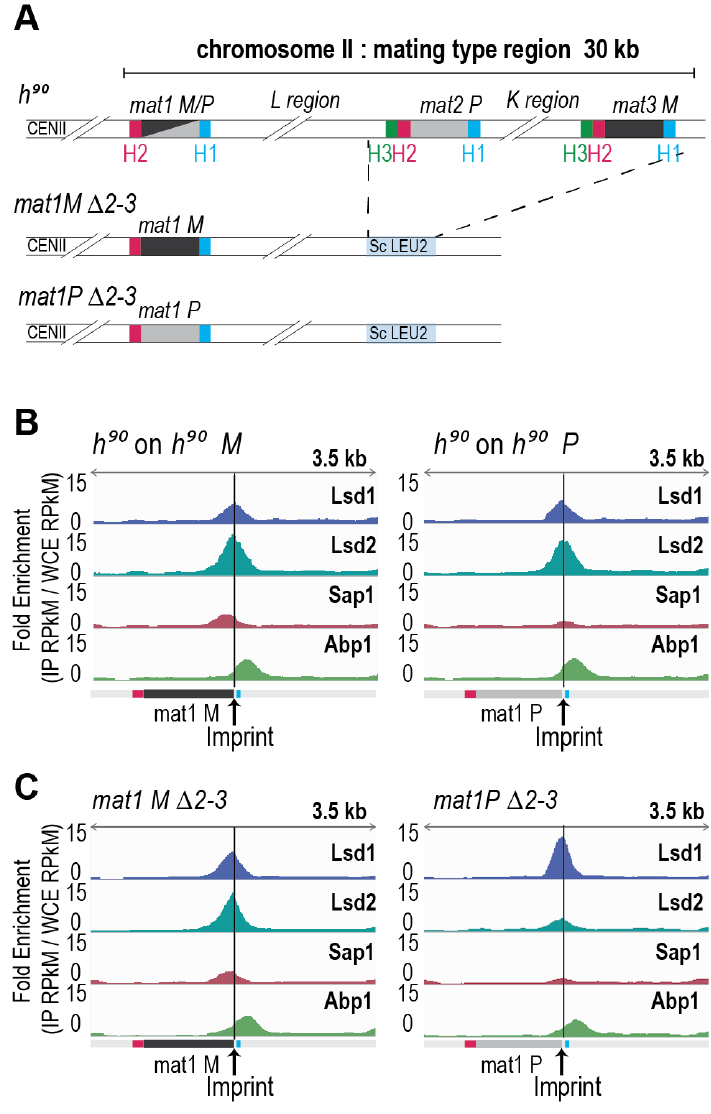
FIGURE 3: Abp1, Lsd1/2 and Sap1 are recruited at mat1. (A) Schematic view of the strains used. The stable mat1M ∆ 2-3 and mat1P ∆ 2-3 strains as well as the wild type h 90 strain are drawn. (B) On the left: distribution of normalized enrichments of the Abp1, Lsd1, Lsd2, and Sap1 ChIPs on the h 90 background (IP RPkM / WCE RPkM). The sequence used for the align- ment is a 44-kb region that contains the MT region with the M allele at mat1 : h 90 M . Only mat1M is shown. On the right: same as at the left, with the h 90 P sequence used for the alignment. Only mat1P is shown. (C) Same as in (B) with the mat1M ∆ 2-3 back- ground on the left and the mat1P ∆ 2-3 background on the right. The sequence used for the alignments is a 10-kb region containing mat1M (for the left panel) or mat1P (for the right panel).( B-C) the imprint site is indicated as well as the H2 (pink) and H1 (blue) ho- mology